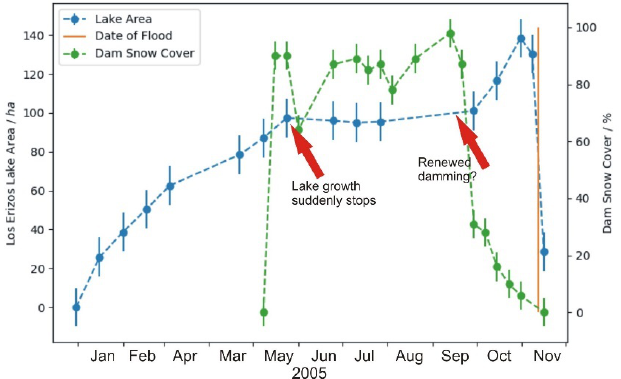
Figure 3. Los Erizos Lake area development showing the two-step lake growth, according to LANDSAT satellite images with visible lake perimeter. The percentage of snow cover over the dam complex is added (c. 20 Has), showing the coincidence of the maximum snow coverage and the second stage of lake growth.